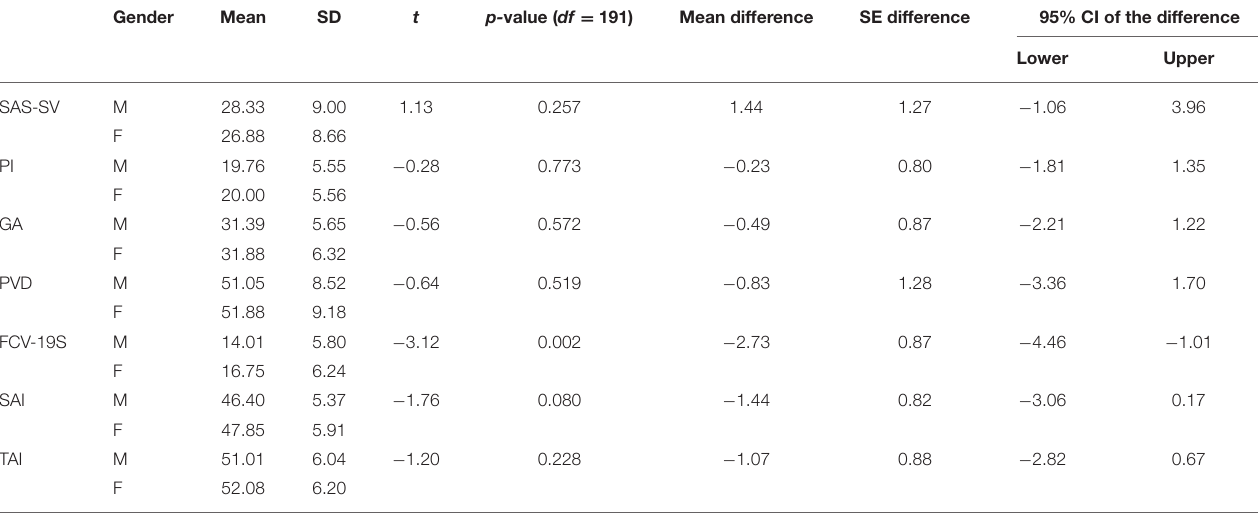
TABLE 1 | Gender differences in FCV-19S, PVD, PI, GA, SAI, TAI, and SAS-SV measured using the t -test of independent samples. Gender Mean SD t Mean difference SE